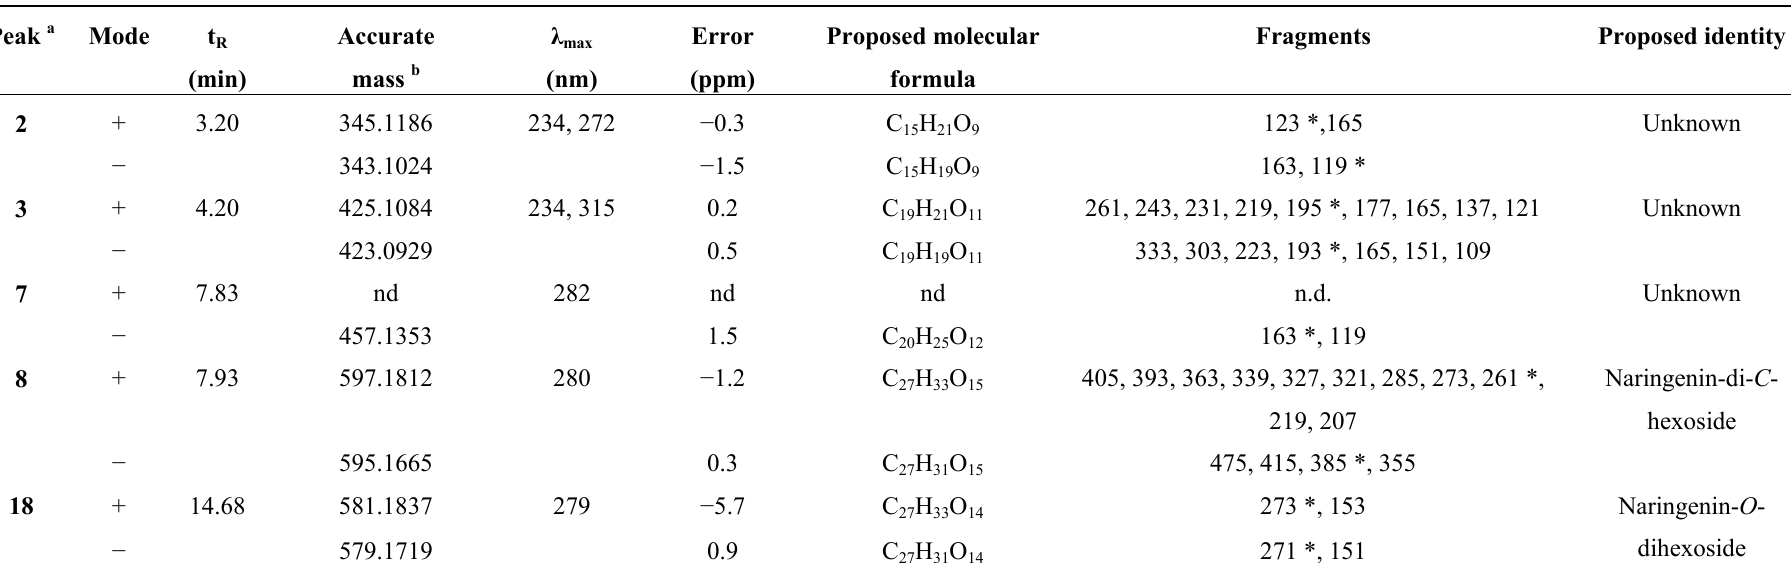
Table 2. UV-Vis, LC-MS and LC-MS/MS characteristics of unidentified compounds in freeze-dried aqueous extracts of green and fermented Cyclopia subternata